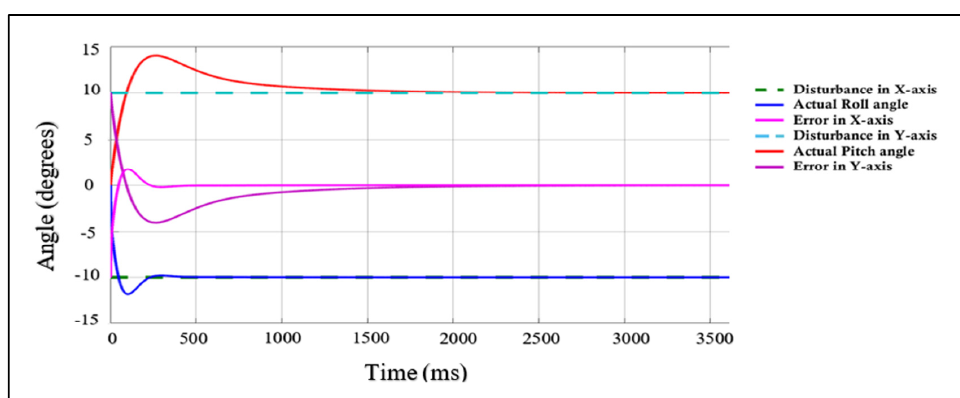
Fig. 14. Self-balancing behavior of simulated model on (contradictory tilt angles in X-axis and Y-axis).